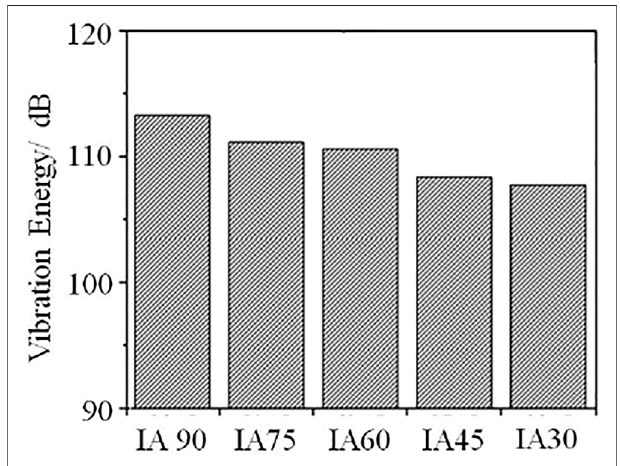
FIGURE 15 | Vibration energy distribution of impeller under different incident